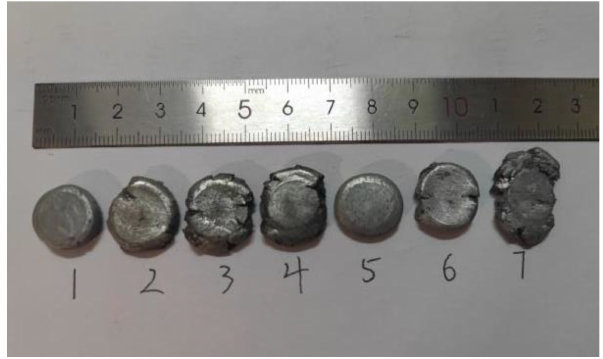
Figure 5. Samples after quasi-static compression.